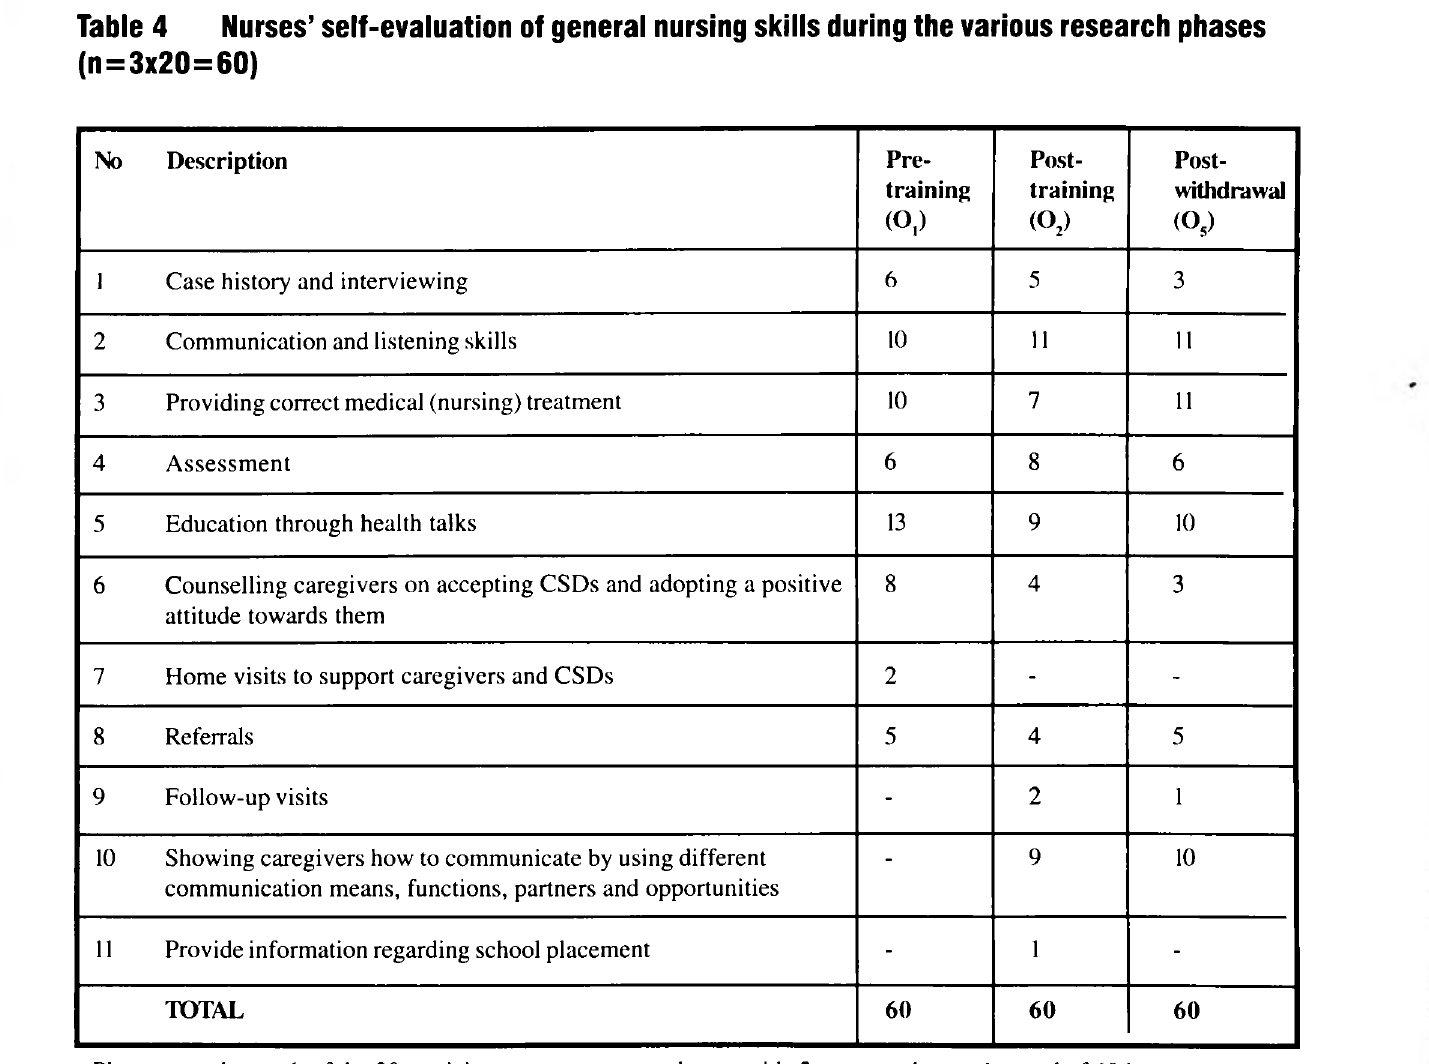
Nurses’ self-evaluation of general nursing skills during the various research